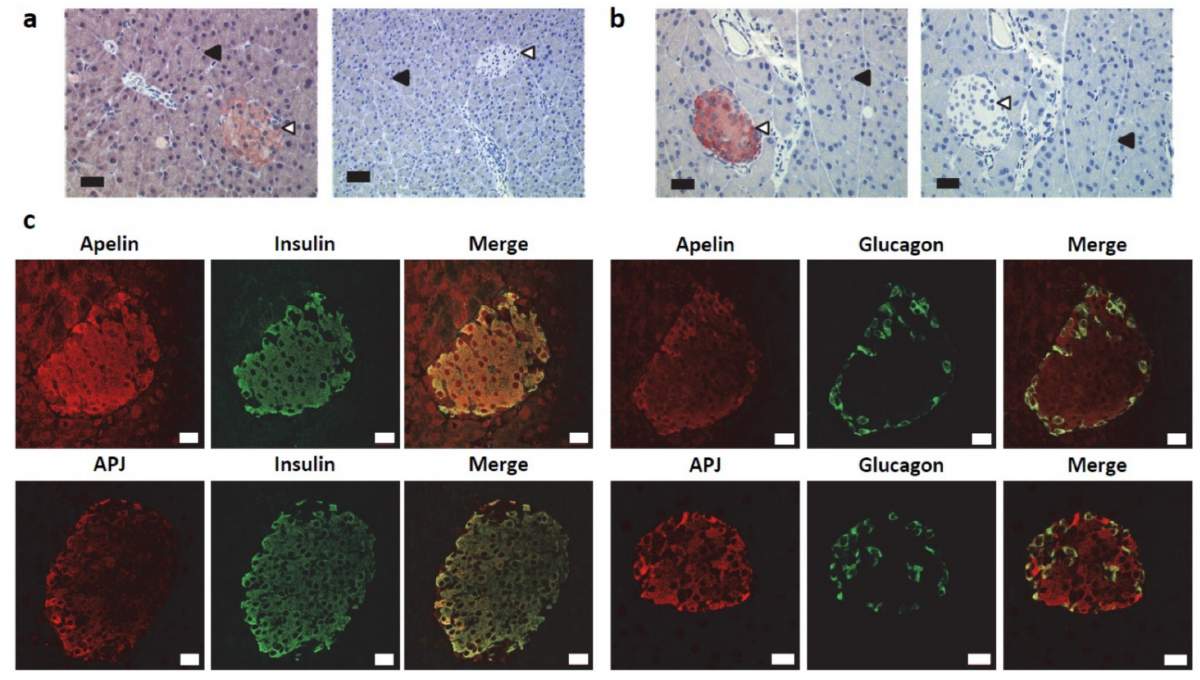
Figure 1. Expression pattern of apelin and apelin receptor in normal murine pancreas. ( a ) Immuno- histochemical staining of apelin on a wild-type mouse (left panel, scale bar, 34 µ m.) and an apelin knock-out mouse pancreatic section (right panel, scale bar, 67 µ m.). Acinar cells (solid triangles) and islets of Langerhans (open triangles) are indicated. ( b ) Immunohistochemical staining of APJ on wild-type mouse pancreatic section. In serial sectioning of pancreas, the staining obtained with the immune serum (left panel) is abolished in the presence of immunogenic peptide (right panel). Scale bar, 34 µ m. ( c ) Confocal pictures of double immunostaining for apelin and insulin (top left), apelin and glucagon (top right), APJ and insulin (bottom left) and APJ and glucagon (bottom right). Scale bar, 20 µ m. Images are representative of nine independent